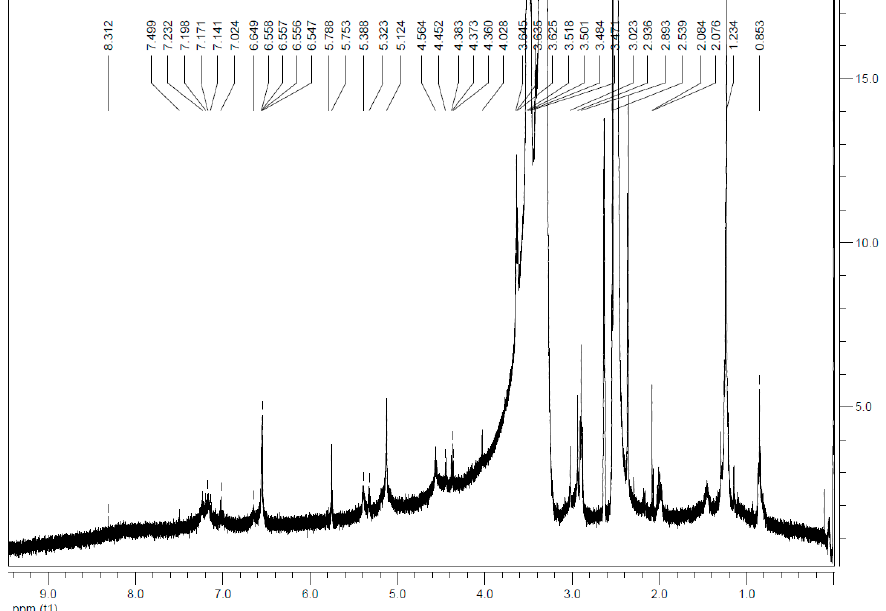
Figure A14. 1 H NMR spectrum of AuNP-RGD 7 in d 6 -DMSO: the characteristic signal of the dou- ble bond of the maleimide is faded; typical signals of peptide-bond-NH (7.50 ppm), Phe-CH arom (7.23–7.14 ppm), Arg-C=NH (6.65 ppm), Arg-NH 2 (5.78 ppm), Phe-CH (5.39 ppm), Asp-CH (5.32 ppm), Arg-CH (4.45 ppm), Lys-CH (4.38 ppm), Gly-CH 2 (4.03 ppm), and residual furan-protected maleimide (6.55, 5.12 and 4.56 ppm).